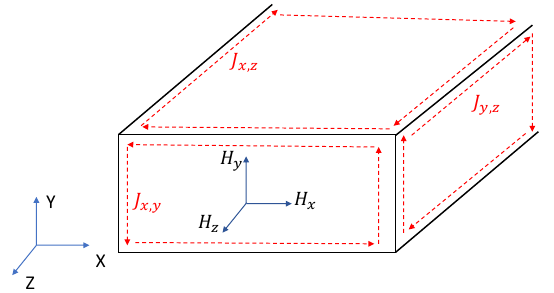
Figure 2. The depiction of eddy current paths here is only representative of the loop they flow in. The actual depth of penetration of the currents will depend on the magnet block dimensions and operating frequency.